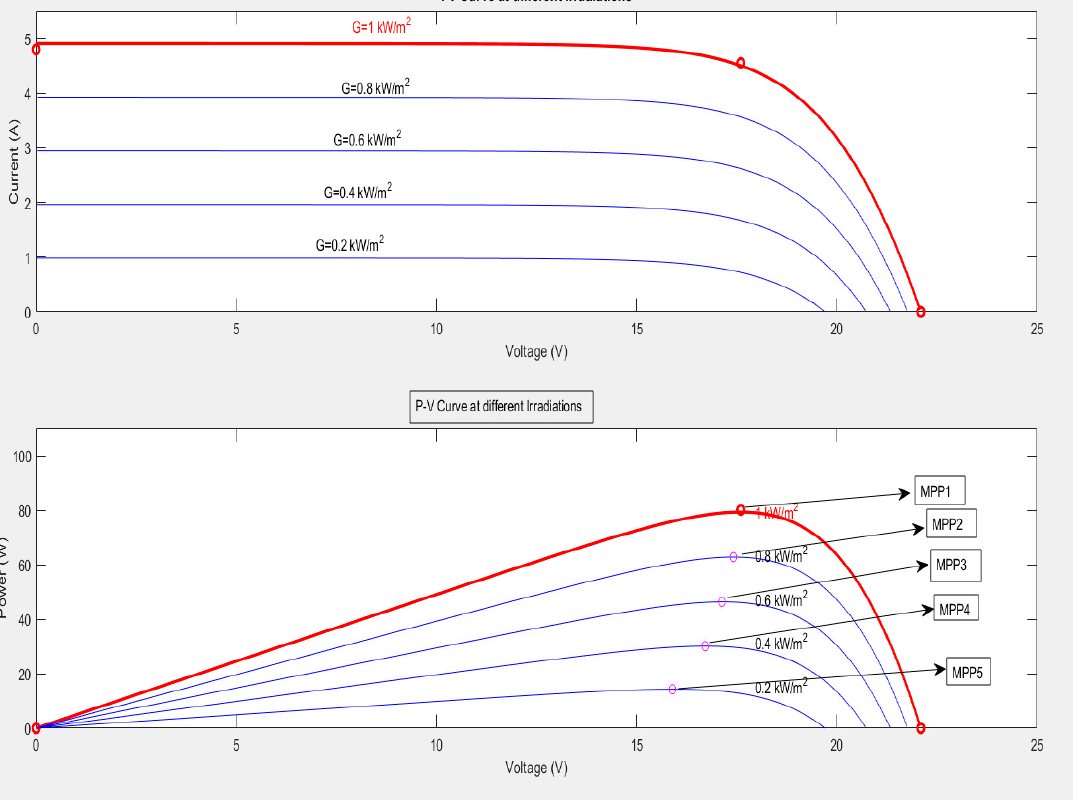
Figure 2. Modelling of the PV array.